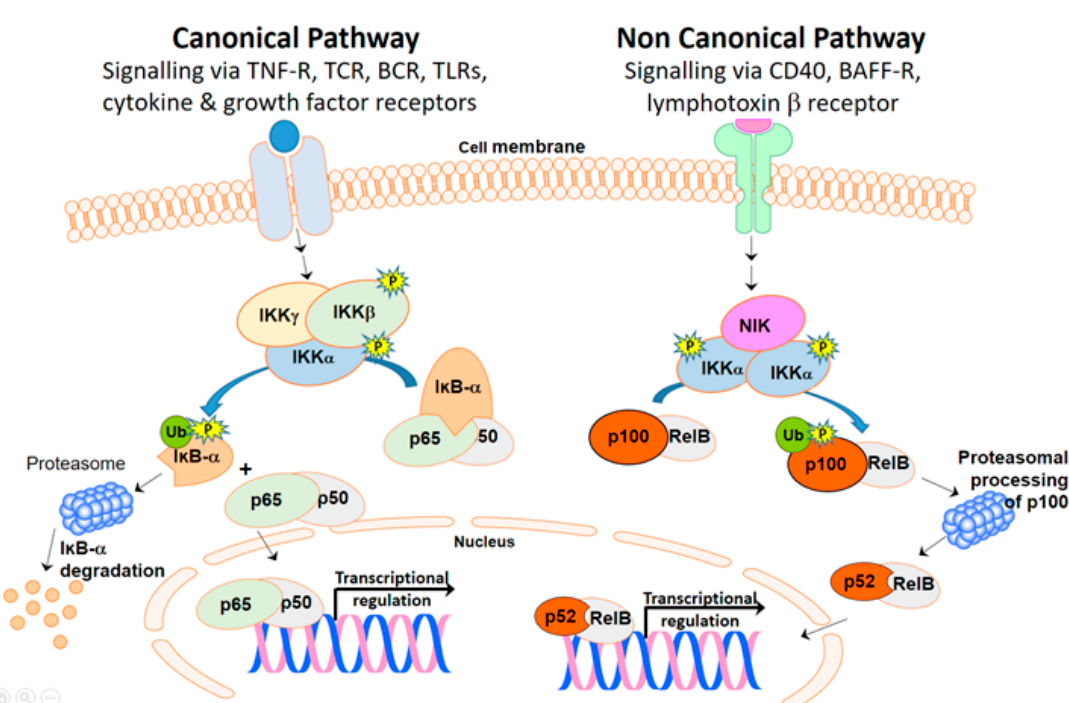
Figure 1. The canonical NF- κ B pathway can be activated via multiple different ligand/receptor interactions. Signaling through these receptors eventually converges on the IKK complex (made up of IKK α , IKK β and IKK γ ) where it causes phosphorylation and activation. Activated IKK triggers the phosphorylation and subsequent degradation of the I κ B- α via the ubiquitin-proteasome, releasing the bound NF- κ B dimer (p65/p50 dimer is shown in this diagram). The NF- κ B dimer can then move into the nucleus and bind to DNA to cause transcriptional regulation. In the non-canonical pathway, signaling via a more limited set of receptors converges on NIK, which then binds to and phosphorylates a dimer of IKK α . Phosphorylated IKK α causes the phosphorylation and ubiquitination of p100, which is complexed to RelB. p100 is cleaved through proteasomal degradation to produce a p52 NF κ B subunit complexed with RelB to form the active NF- κ B heterodimer, which can then move into the nucleus and bind to DNA to cause transcriptional regulation. Abbreviations: TNFR, Tumor Necrosis Factor Receptor; TCR, T cell receptor; BCR, B cell receptor; TLRs, toll-like receptors; BAFF-R, B-cell activating factor receptor; Ub, ubiquitin.